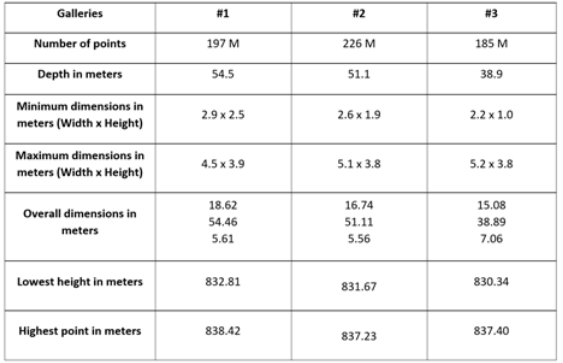
Table 1 : Statistics of different gallery acquisitions. The next processing step consisted of the fusion in a hybrid model of the model based on the geometry from TLS point cloud, supplemented to fill holes by extracts from the dense point cloud obtained by photogrammetry.